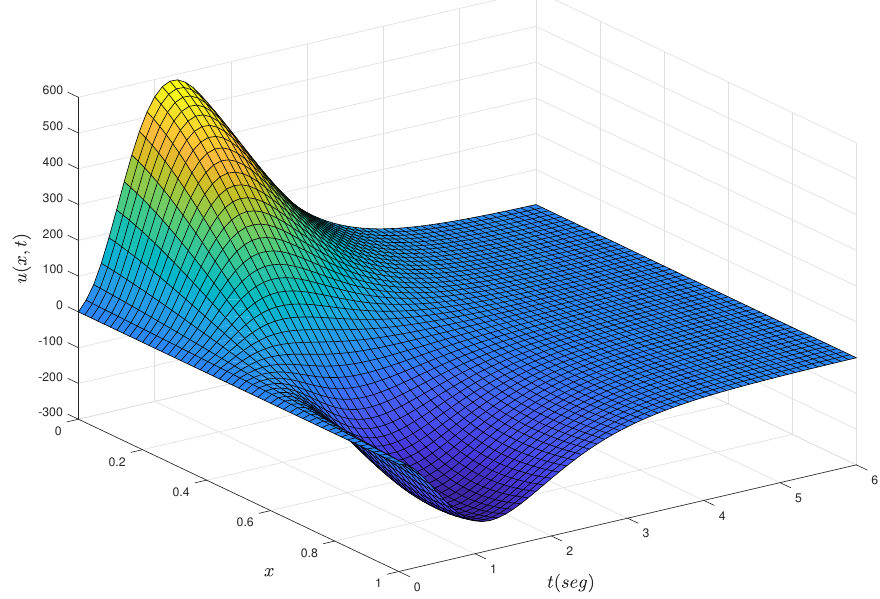
Figure 2. Dynamics in closed-loop of the adaptive boundary controller.